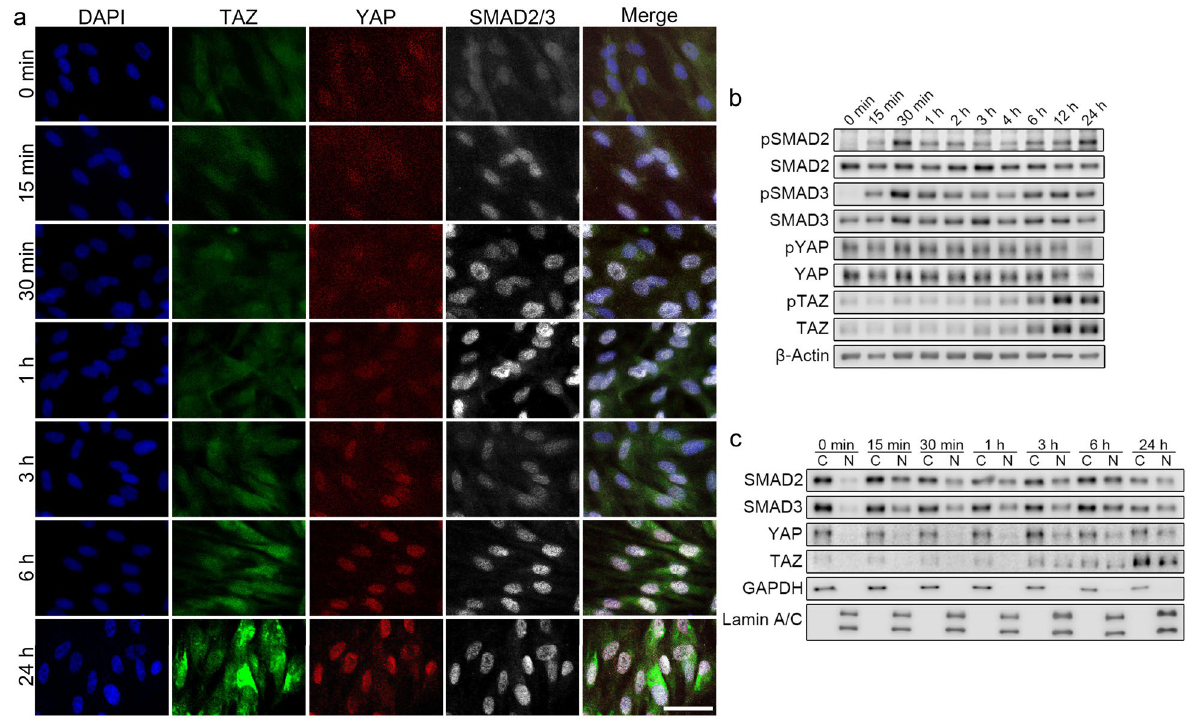
Figure 6. TGF-β1 concurrently activated SMAD2/3 and YAP/TAZ in HVOX fibroblasts. HVOX fibroblasts were treated with 10 ng/mL TGF-β1 for 0, 15, and 30 min and 1, 2, 3, 4, 6, 12, and 24 h ( a , b ). Distributional changes of YAP, TAZ, and SMAD2/3 were assessed by immunostaining ( a ; bar = 50 µm). Western blotting was performed to detect Ser465/467-phosphorylated SMAD2 (pSMAD2), SMAD2, Ser423/425-phosphorylated SMAD3 (pSMAD3), SMAD3, Ser127-phosphorylated YAP (pYAP), YAP, Ser89-phosphorylated TAZ (pTAZ), TAZ, and β-actin in the total cell fraction ( b ). HVOX fibroblast were treated with 10 ng/mL TGF-β1 for 0, 15, and 30 min and 1, 3, 6, and 24 h ( c ). Western blotting was performed to detect SMAD2, SMAD3, YAP, TAZ, GAPDH, and lamin A/C in the cytoplasmic (C) and nuclear (N) fractions. In ( b ) and ( c ), representative grouping of gels cropped from different parts of the same gel or from different gels; whole gels available in supplemental material.